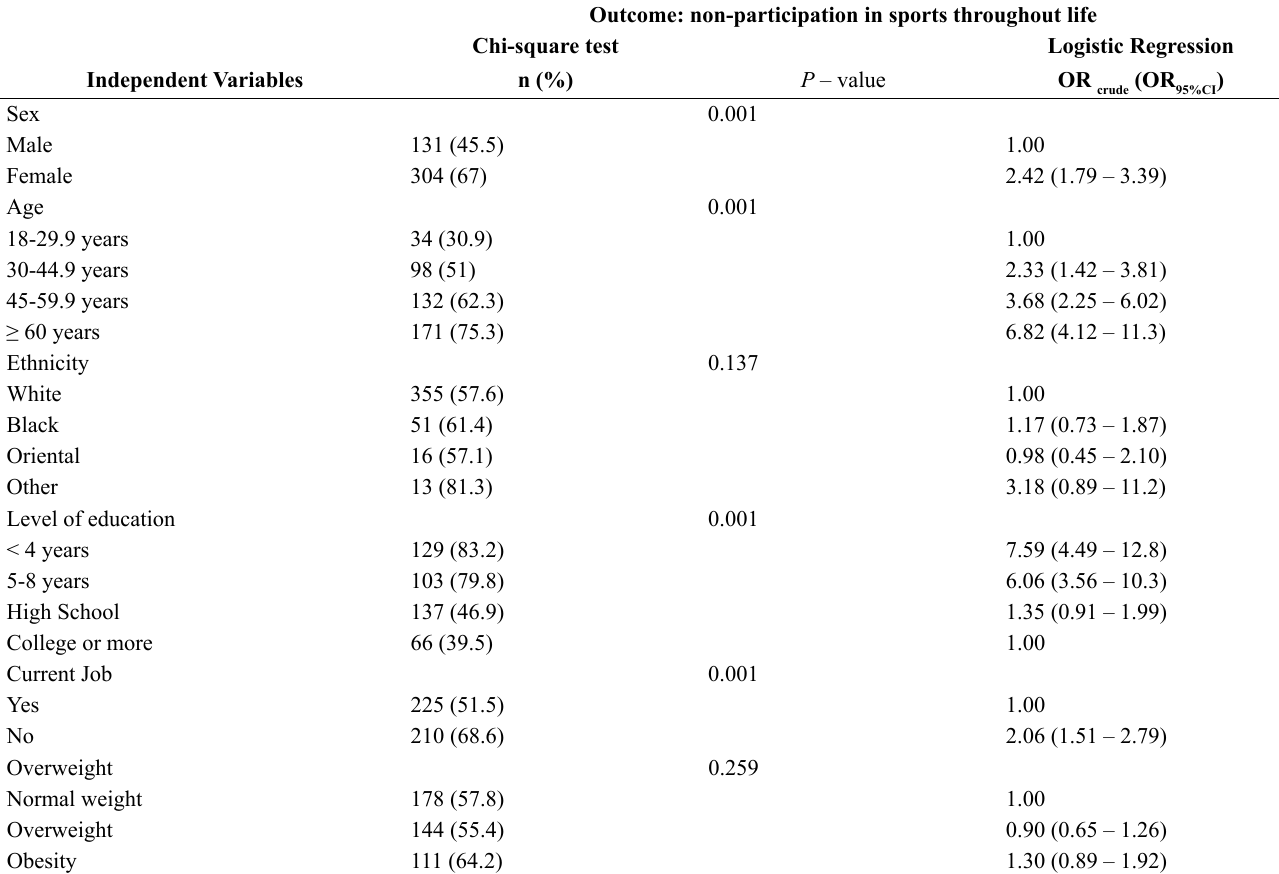
Table 2. Association between non-participation in sports throughout life and independent variables. Outcome: non-participation in sports throughout life Chi-square test Logistic Regression